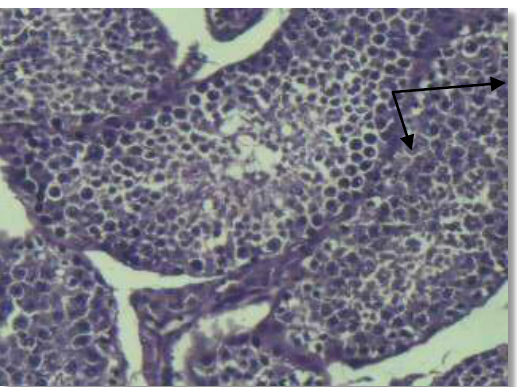
Figure (6): Histopathological section of ram testis (November) showing normal structure appearance of testicular tubules with different stages of spermatogenesis active and large spermatogonium cells (arrows) on a basement of tubule. HE stain